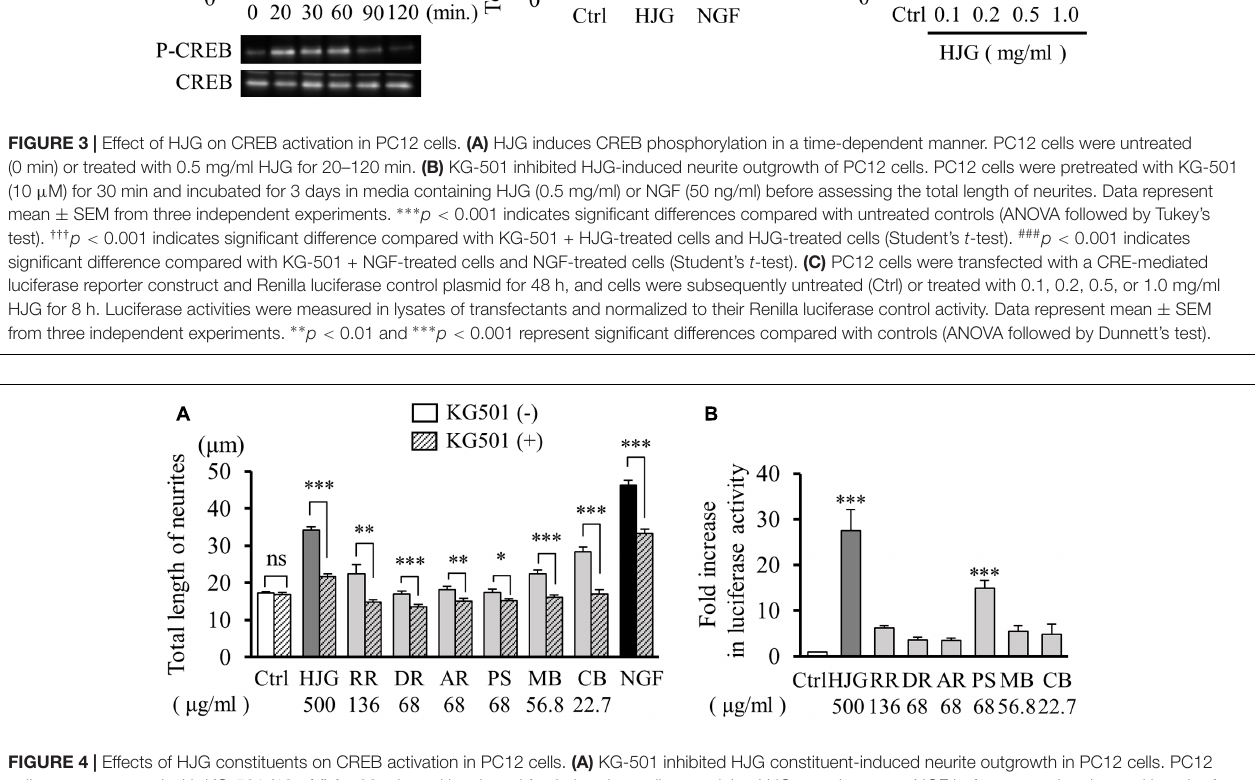
FIGURE 4 | Effects of HJG constituents on CREB activation in PC12 cells. (A) KG-501 inhibited HJG constituent-induced neurite outgrowth in PC12 cells. PC12 cells were pretreated with KG-501 (10 µ M) for 30 min and incubated for 3 days in media containing HJG constituents or NGF before assessing the total length of neurites. Data represent mean ± SEM from three independent experiments. ∗ p < 0.05, ∗∗ p < 0.01, and ∗∗∗ p < 0.001 indicate significant differences between KG-501 and each HJG constituent treated cells and no-treated KG-501 constituent treated cells (Student’s t -test). (B) PC12 cells were transfected with a CRE-mediated luciferase reporter construct and Renilla luciferase control plasmid for 48 h, and cells were subsequently treated with HJG constituents for 8 h or left untreated as a control. Luciferase activities were measured in lysates of transfectants and normalized to their Renilla luciferase control activity. Data represent mean ± SEM from three independent experiments. ∗∗∗ p < 0.001 represents significant differences compared with controls (ANOVA followed by Dunnett’s